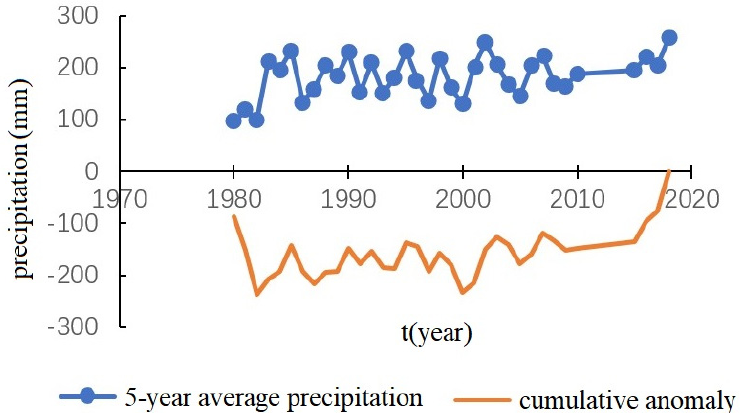
Figure 7. Average annual precipitation and cumulative anomaly curves of the northern Yellow River diversion irrigation area